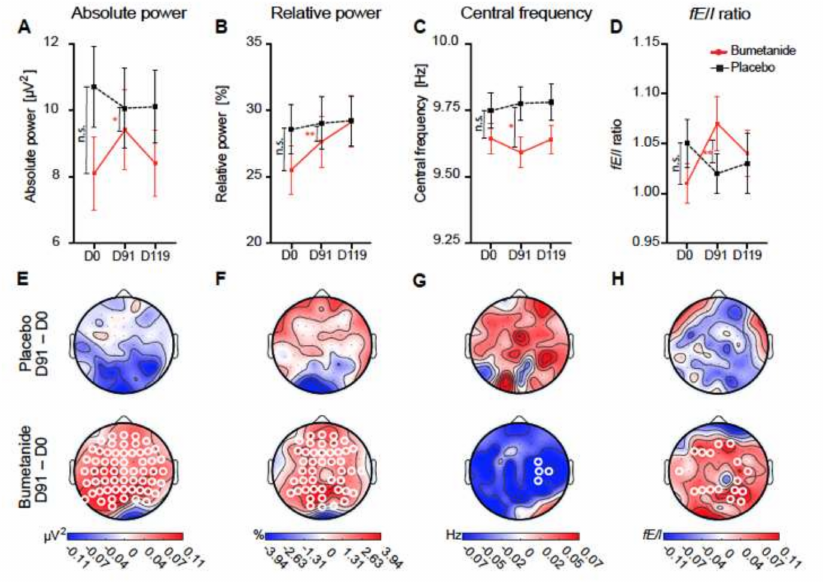
Figure 4. Bumetanide, but not placebo, affects alpha oscillations in children with ASDs: ( A – D ) whole- brain average EEG measures at treatment time points. Grand average topographies of the treatment on EEG measures. Significant changes are shown with white circles in ( E – H ); these are exclusively present in treated children, not placebo. This is observed in absolute EEG power, relative power, and fE/I ratio. Adapted with permission from